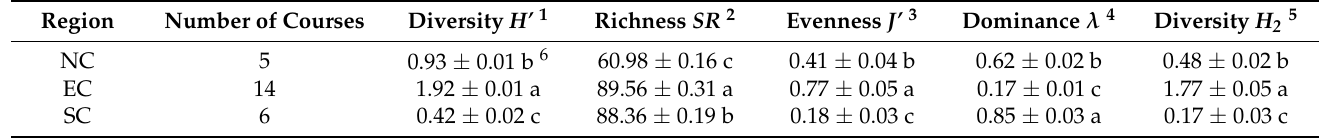
Table 5. Diversity of plant-parasitic nematodes in North, South, and East China.